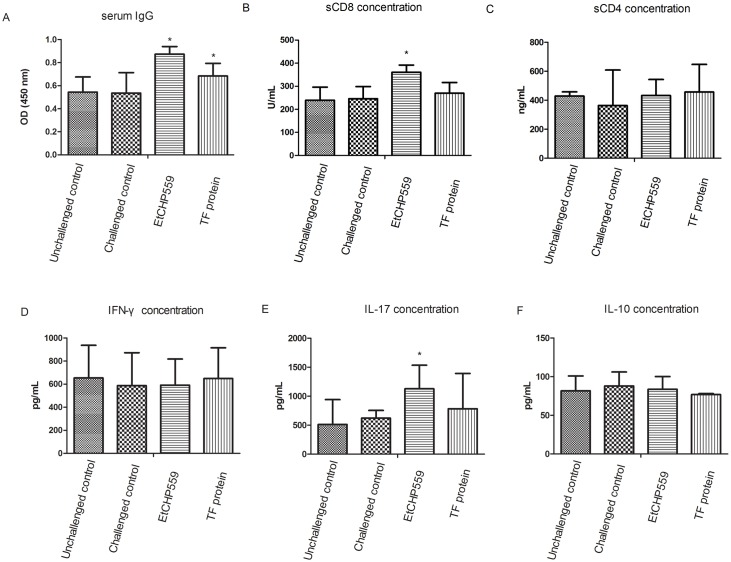
Serum rEtCHP559 IgG, the concentrations of sCD4, sCD8 and cytokine levels in chickens.Chickens were immunized with rEtCHP559 protein and TF protein. The IgG titers and the concentrations of sCD4, sCD8 and cytokine are expressed as mean ± SD. * represents a significant difference (P<0.05), otherwise there was no difference (P>0.05). A: IgG; B: sCD8; C: sCD4; D: IFN-γ; E: IL-17 and F: IL-10.